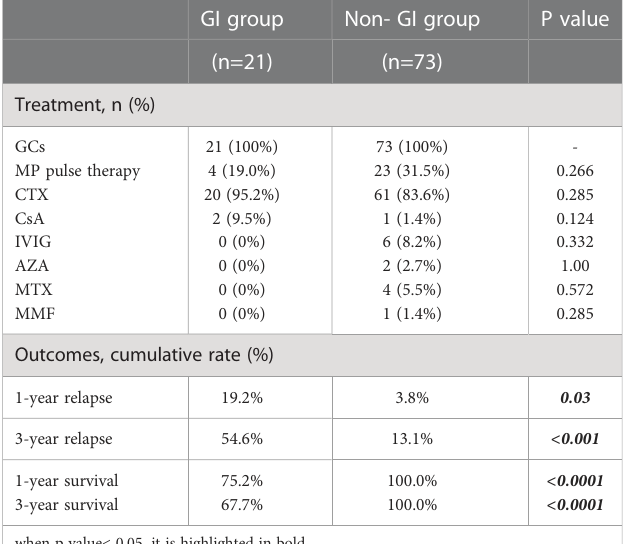
TABLE 5 Induction treatment and outcomes of EGPA patients with and without GI involvement. GI